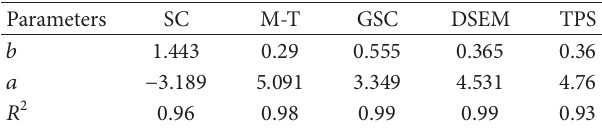
Table 6: Fitting parameters at 10 Hz.